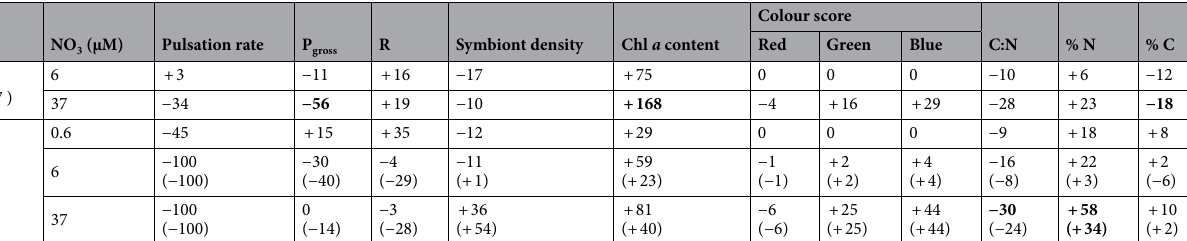
Table 1. Effect size (%) of ecophysiological parameters relative to controls (LN; ~ 0.6 μM NO 3 , no warming). Bold values indicate significant differences to controls (LN) and values in brackets indicate effect size